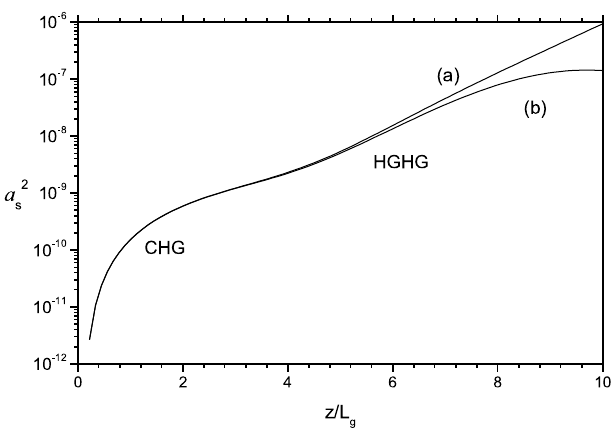
FIG. 1. (a) The linear approximation [Eq. (22)] compared with (b) the result given by numerically solving Eqs. (1) and